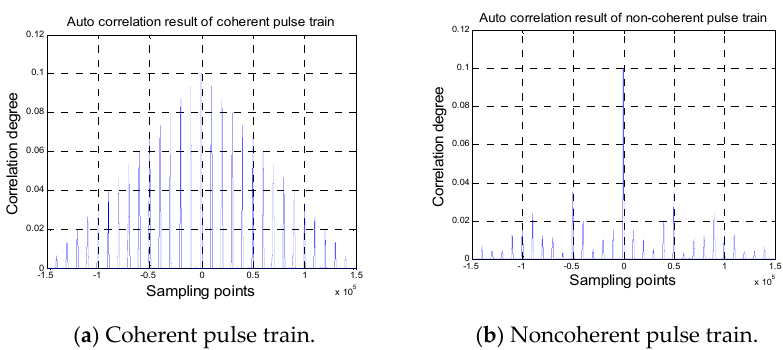
( a ) Coherent pulse train. ( b ) Noncoherent pulse train. Figure 4. Autocorrelation result of coherent and noncoherent pulse trains; signal type is nonlinear frequency modulation (NLFM).